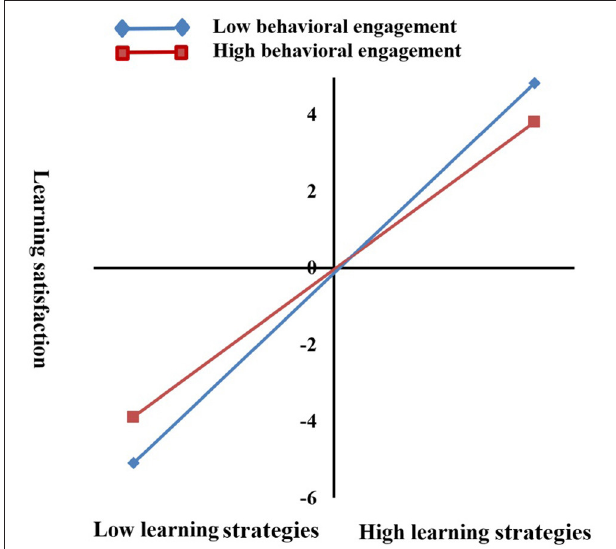
FIGURE 5 | The influence of learning strategies on learning satisfaction: a simple slope figure of the moderating effect.